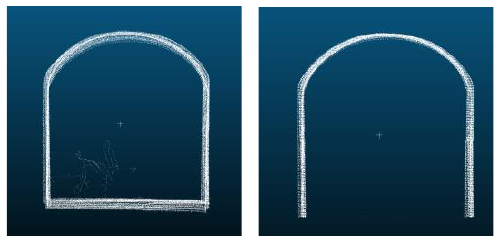
Figure 1 . Original tunnel point cloud (left) and model filtered effect